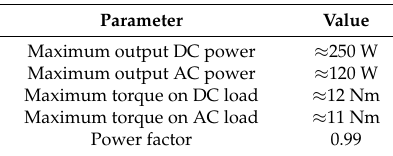
Table 6. Summary of measured power characteristics for prototype magnetic geared generator.